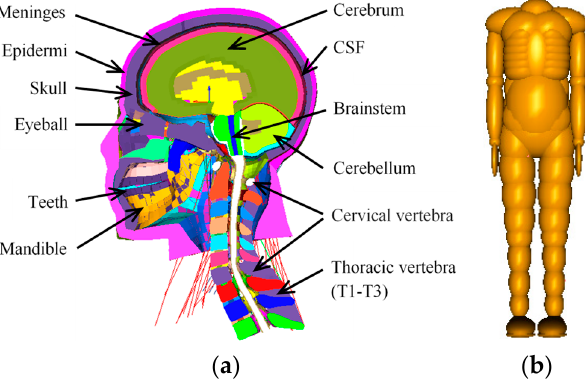
Figure 1. ( a ) Extracted head–neck finite element (FE) model; ( b ) extracted pedestrian multibody model.